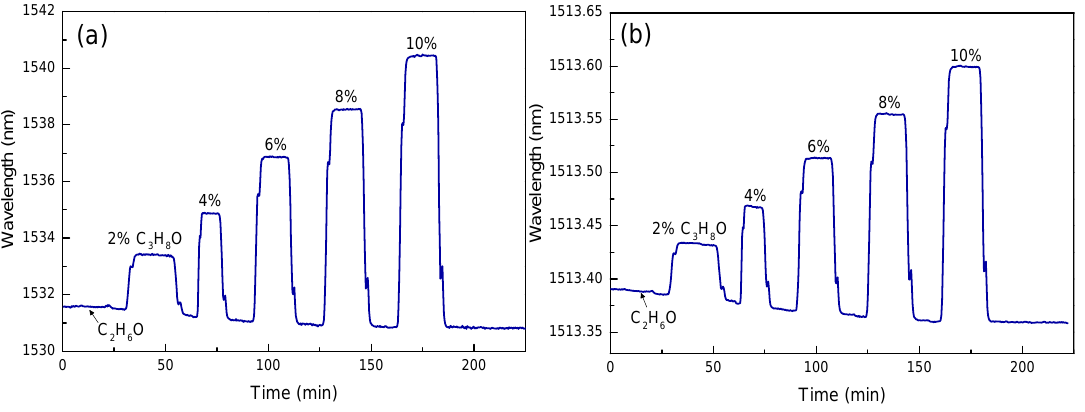
Figure 4. Real-time monitoring of the wavelength shift of isopropanol (C (C H O) mixtures for: ( a ) the CMRRs-based sensor and ( b ) the single sensor 2 6